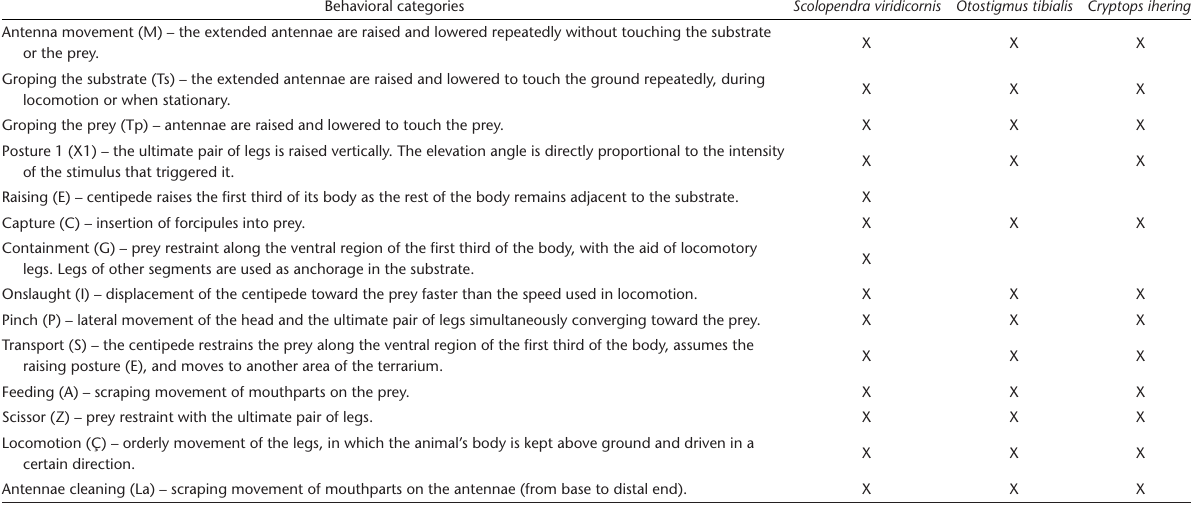
Table 1. Predatory behavior categories observed among the three centipede species studied in the experiment conducted in the Arthro- pods Laboratory of the Instituto Butantan (São Paulo,